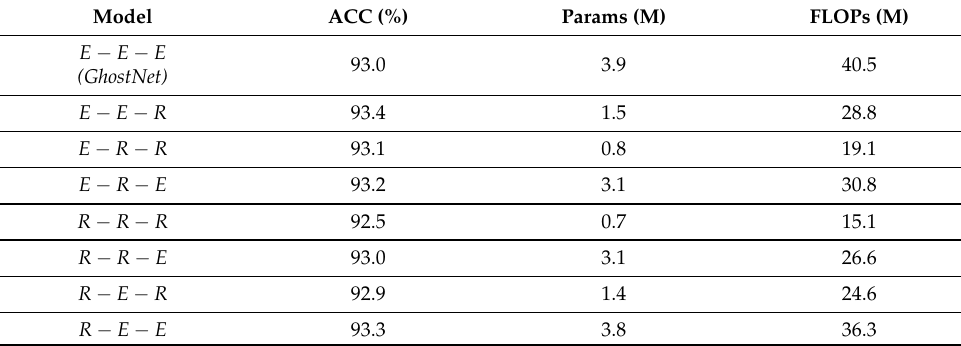
Figure 5. Visualization of the nuclear norm of the blocks of GhostNet and GhostNeXt on STL-10. Table 6. Results with respect to different module configurations on